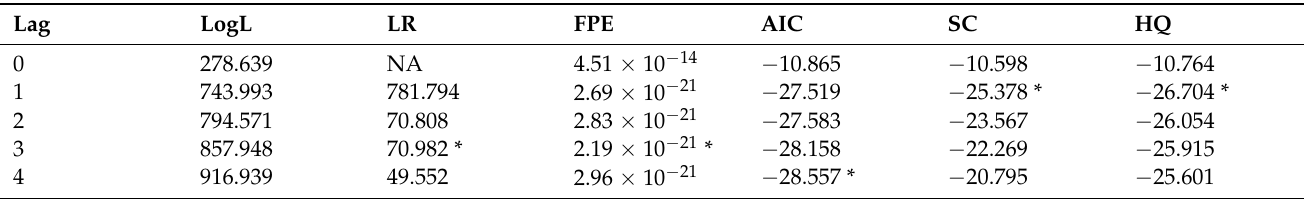
Table 4. VAR lag order selection criteria